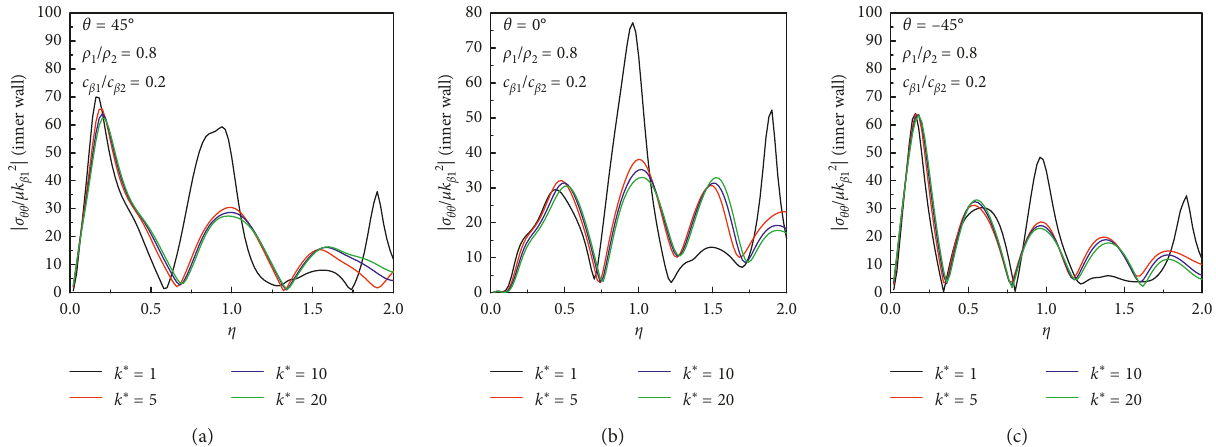
Figure 8: DSCF spectrum distribution on the inner lining wall surface under the vertically incident SV wave: (a) θ (c) θ (cid:29)